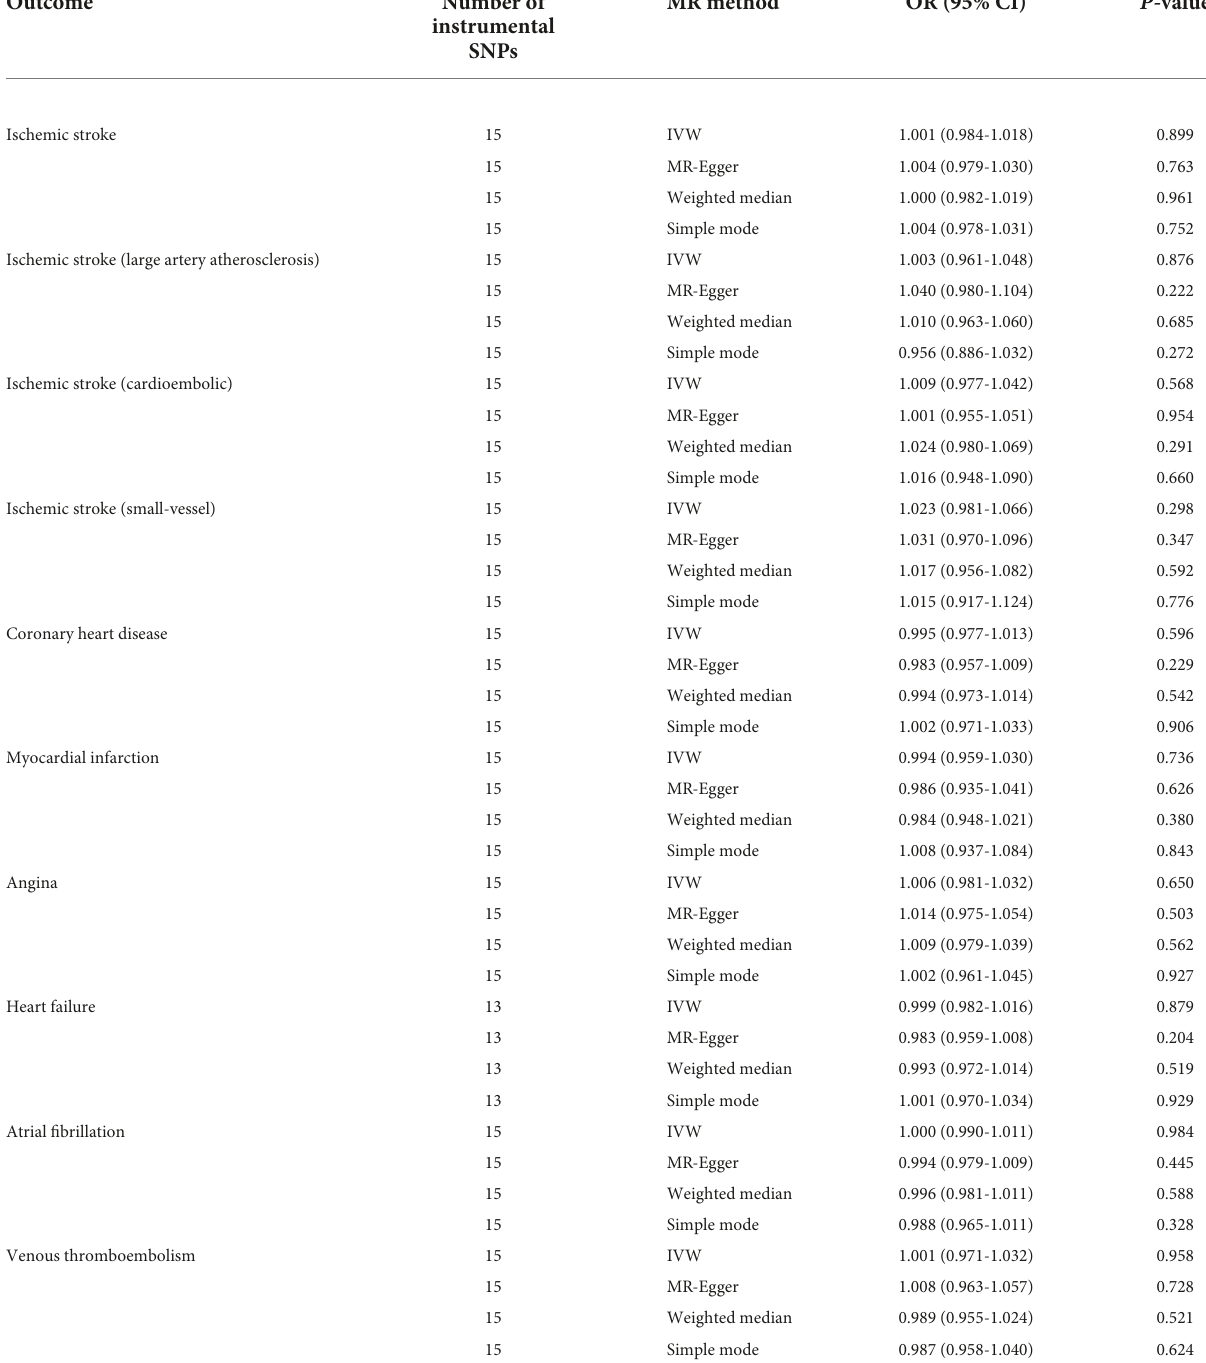
TABLE 2 Assessing the cause effect of celiac disease on cardiovascular diseases. Outcome Number of